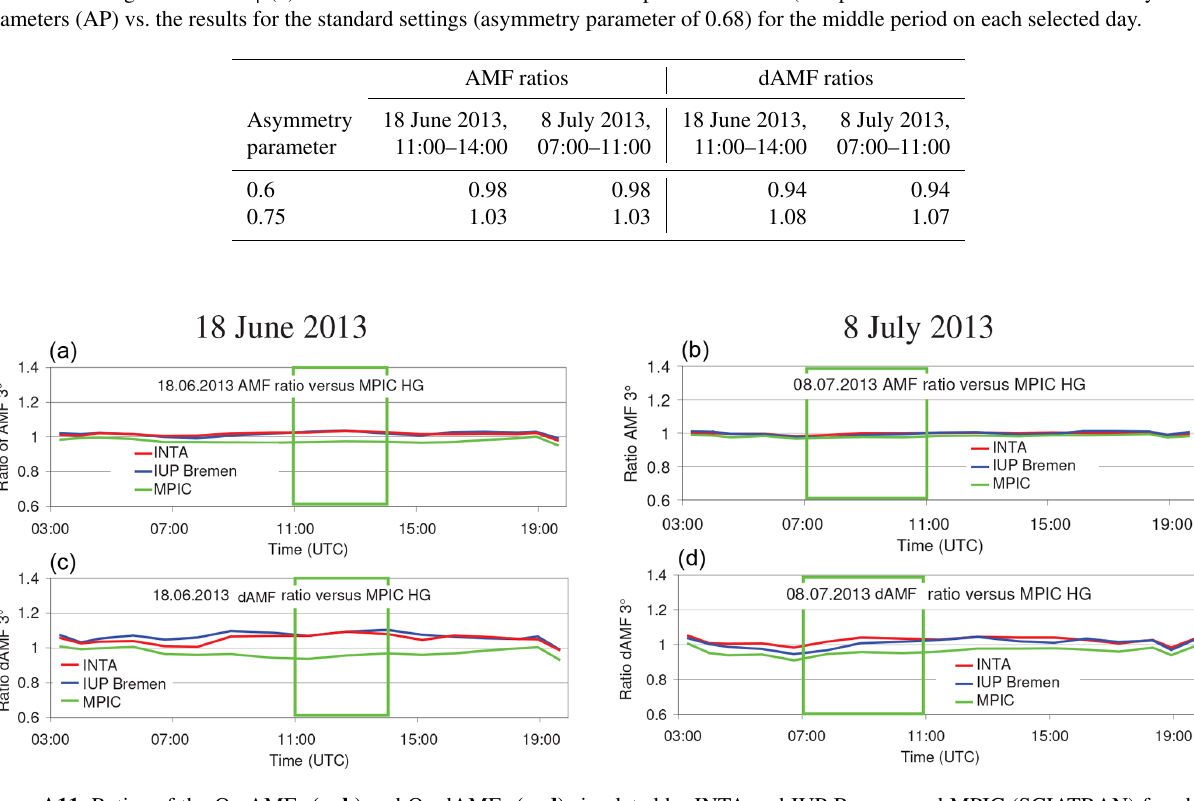
Figure A11. Ratios of the O 4 AMFs (a, b) and O 4 dAMFs (c, d) simulated by INTA and IUP Bremen and MPIC (SCIATRAN) for phase functions derived from the sun photometer measurements vs. those simulated by MPIC using the Henyey–Greenstein phase function for an asymmetry parameter of 0.68 for both selected